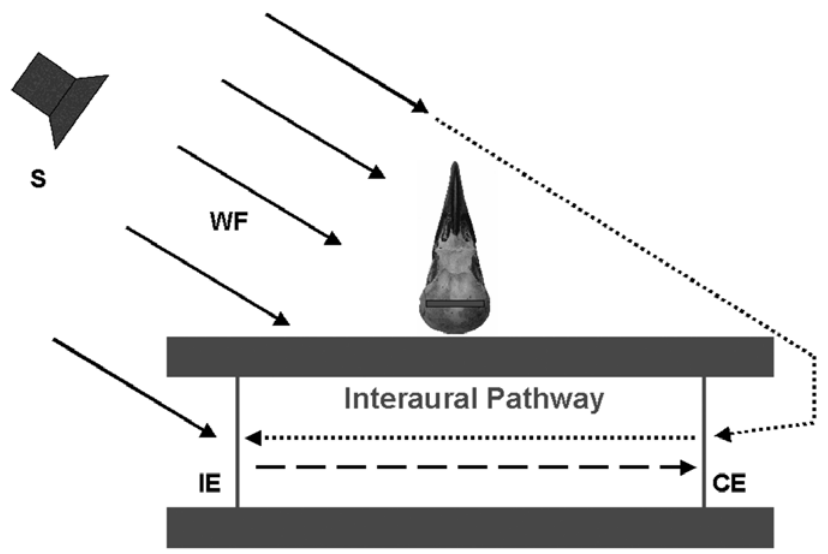
Fig. 1 – Sound transmission through the interaural canal turns the bird ears into coupled and inherently directional pressure difference receivers. The speaker located at an azimuth angle of 45 ◦ emits a sound wave, which reaches the external surface of the ipsilateral eardrum, the movement of which transmits sound through the interaural canal. The transmitted sound is delayed and attenuated relative to the impinging sound. The same sequence of events happens at the contralateral eardrum. The resulting movement of the two eardrums is determined by the net force working on their respective internal and external surfaces, here indicated by oppositely directed arrowheads. Inset shows the approximate position of the interaural canal in the skull of a Hooded Crow Corvus cornix . S: Speaker; WF: wave front; IE: ipsilateral ear; CE: contralateral